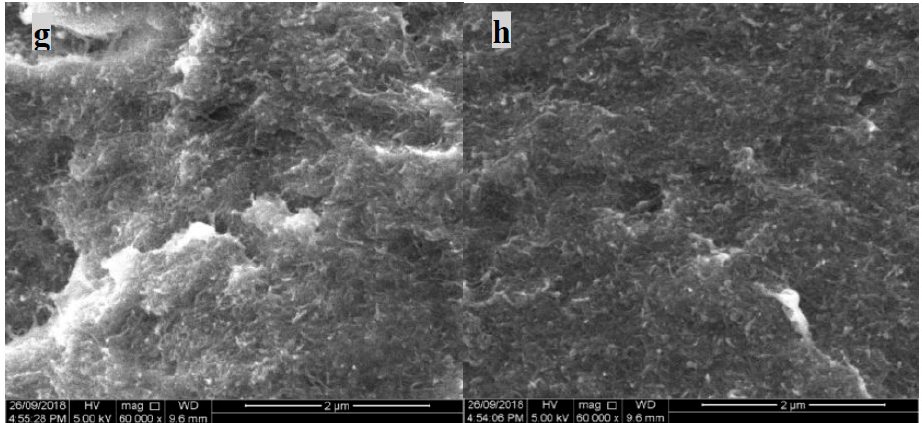
Figure 7. SEM image (Anterior) of MWNT/PVDF composite: ( a ) PVP@MWNT/PVDF composites; ( b ) PVP 10000 at 2.44 wt %; ( c ) PVP 40000 at 9.09 wt %; ( d ) PVP 55000 at 23.08 wt %, SEM image (fractured side view) of MWNT/PVDF composite; ( e ) PVP@MWNT/PVDF composites; ( f ) PVP 10000 at 2.44 wt %; ( g ) PVP 40000 at 9.09 wt % and ( h ) PVP 55000 at 23.08 wt %.